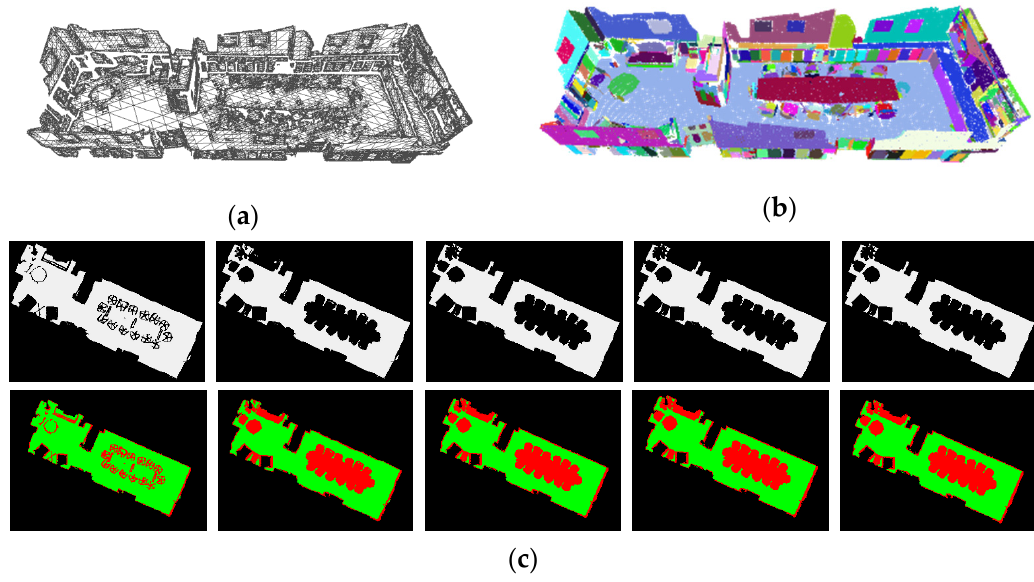
Figure 19. Indoor structure extraction (ISE) result of real dataset 1: ( a ) feature structure map (FSM) result, ( b ) original planar point cloud, and ( c ) PAM.